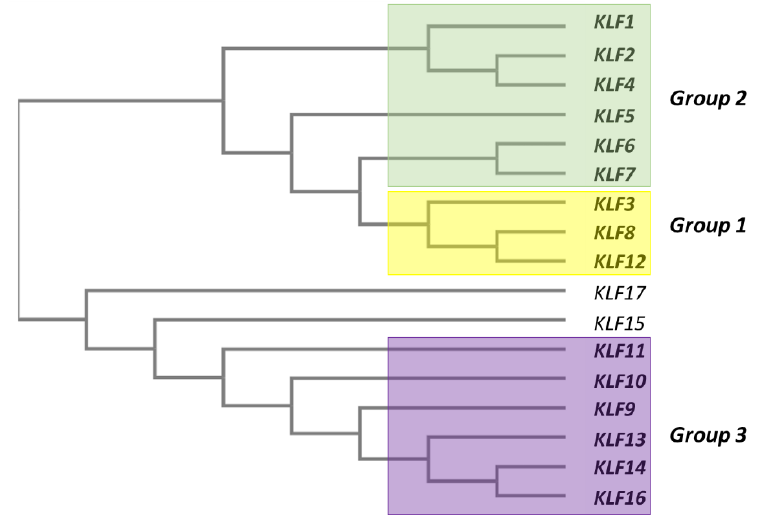
Figure 2. A human KLF family phylogenetic tree generated using the Clustal Omega tool (https://www.ebi.ac.uk/Tools/msa/clustalo/). There are 17 members of the human KLF family, which can be further classified into three subgroups. KLF7 is the closest to KLF6 in the phylogeny.